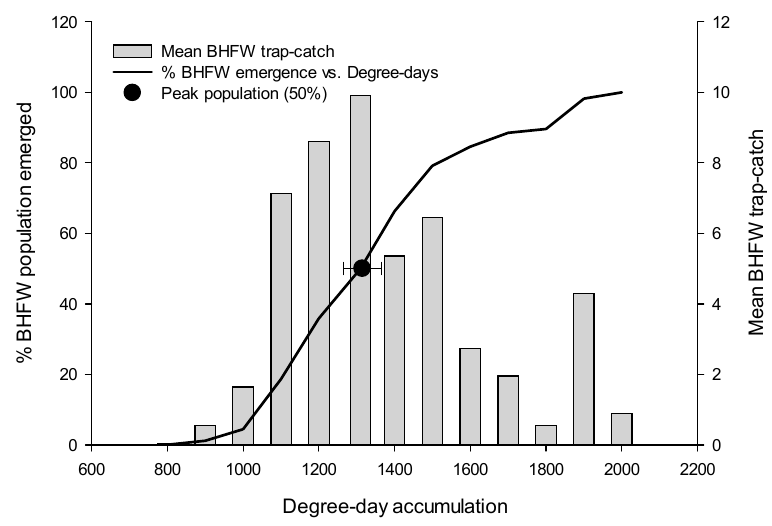
Figure 3. Blackheaded fireworm (BHFW) flight (% emergence, trap-catch, and peak flight) plotted as a function of degree-day accumulation. The peak flight interval (the halfway point, indicated by the black circle, ±95% CI) represents the range of degree-days within which peak flight is most likely to occur.